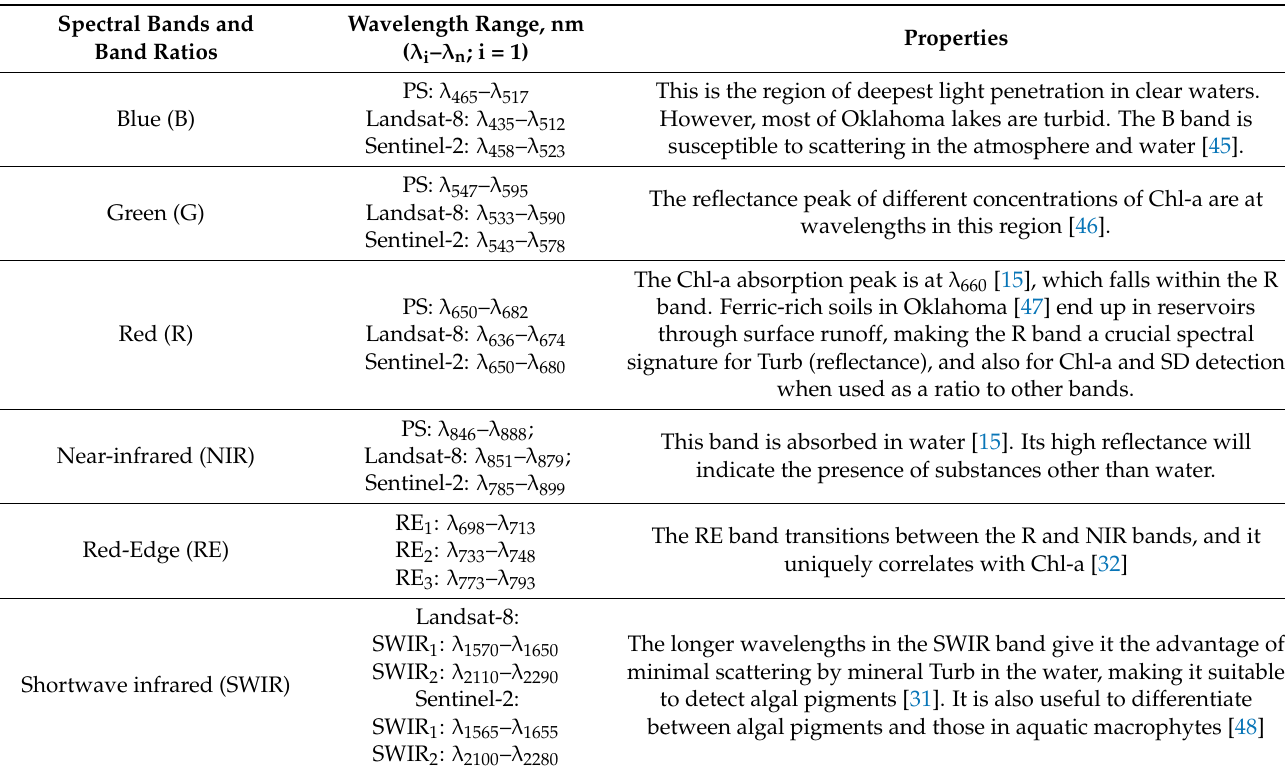
Table 3. Spectral bands and their spectral properties that allow for monitoring Chl-a, Turb, and SD. Spectral Bands and Wavelength Range, Band Ratios